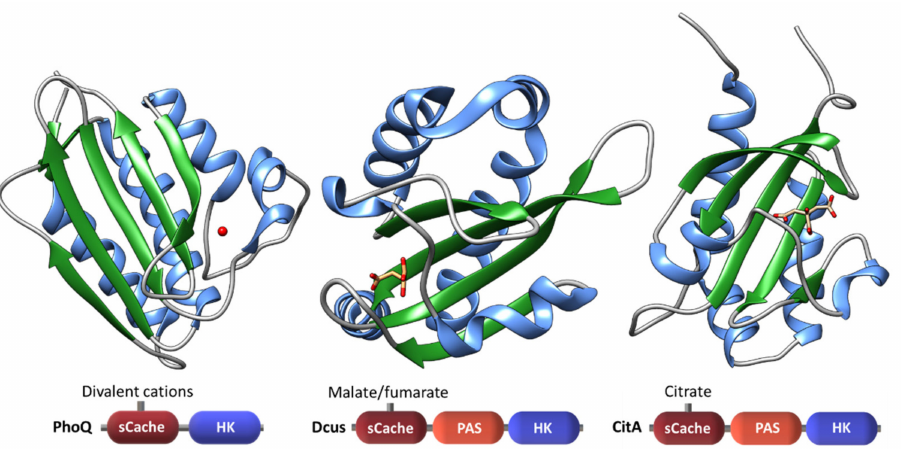
Figure 5. Structure of the sCache domains of PhoQ (PDB: 1ID0) from Salmonella enterica , DcuS (PDB: 3BY8) from E. coli and CitA (PDB: 1P0Z) from K. pneumoniae . The ligands of each sCache domain are also represented: Mg 2+ (red), malate (coloured by element) and citrate (coloured by element). The β -strands and α -helices are colored green and blue, respectively. The sensor domain architectures are shown at the bottom of